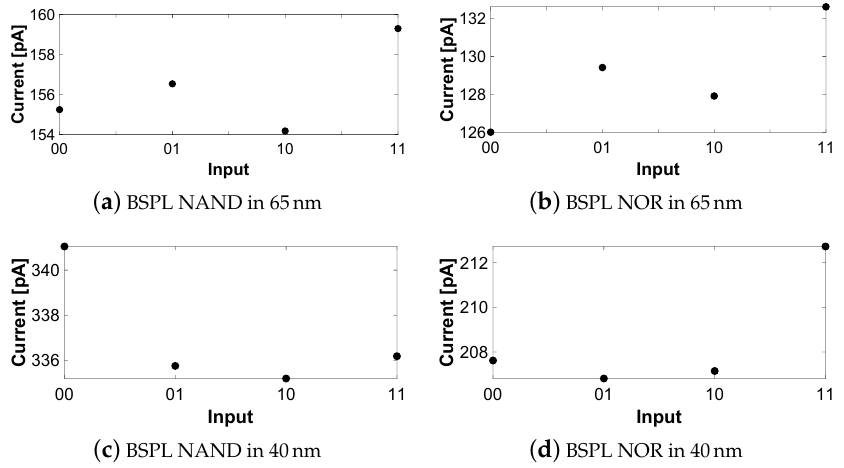
Figure 5. Input-dependent static leakage currents in BSPL NAND and NOR gates in 65nm and 40nm